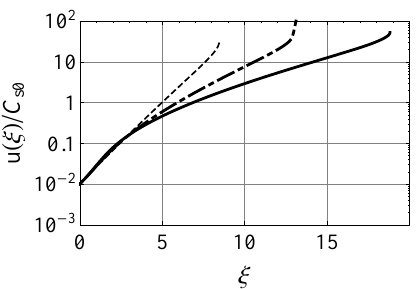
Figure 6. Variation of normalised density with normalised altitude for the three cases shown in Fig.